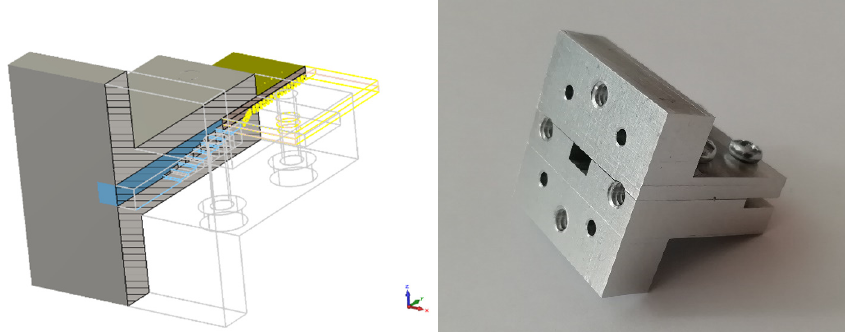
Figure 8. WR15 to SIW transition.